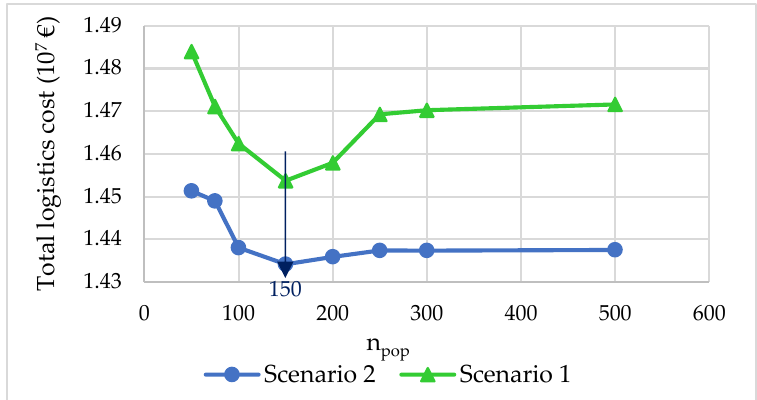
Figure 10. Representation of the population size setting for the GA.